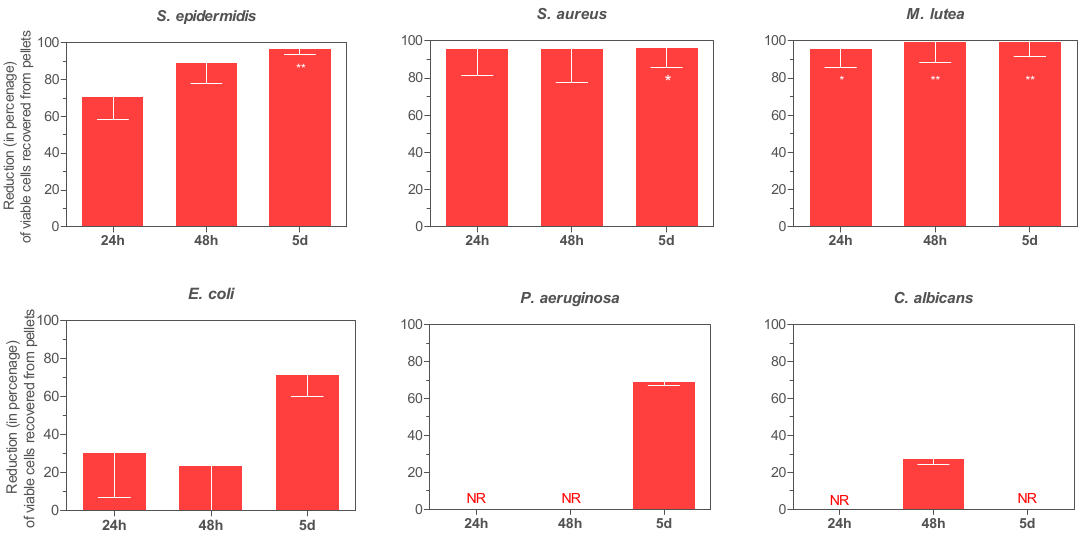
Figure 5. Effect of ZnO35 on the viability of bacterial and yeast biofilms. NR; no reduction. * p < 0.05, ** p < 0.01.